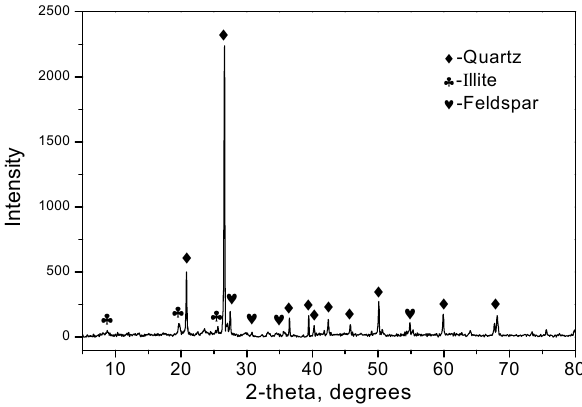
Figure 4. XRD patterns of calcined Hwangtoh powders.